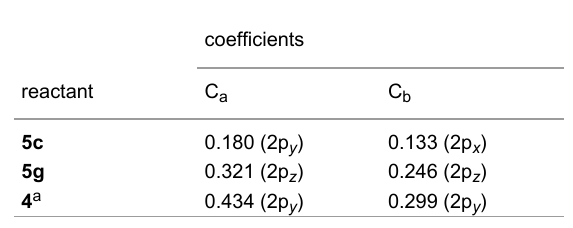
Table 3: FMO coefficients of the 1,3-dipole 4 and representative dipo- larophiles (atomic orbital is indicated in